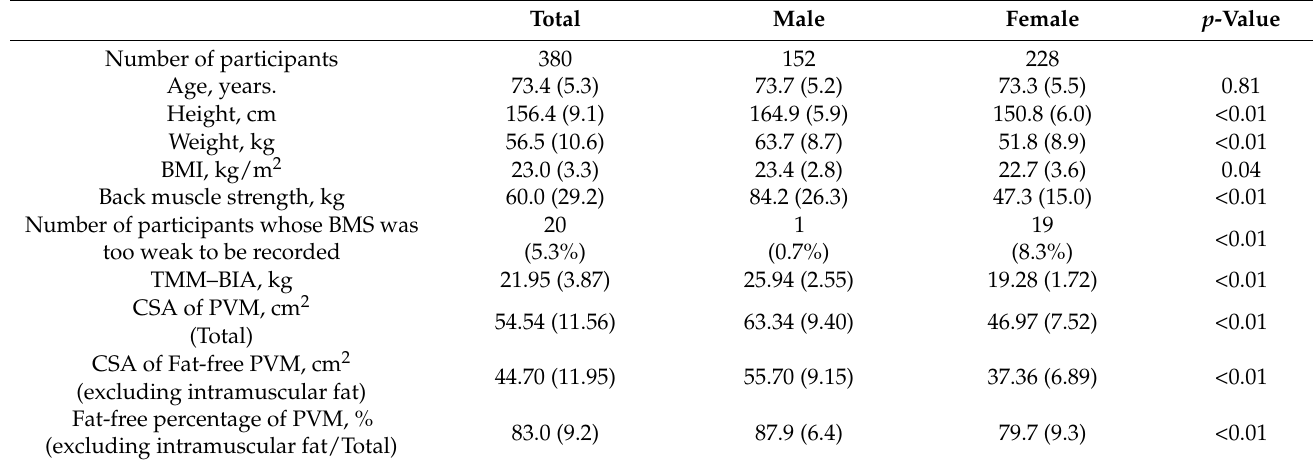
Table 1. Characteristics of the participants of the Shiraniwa study.